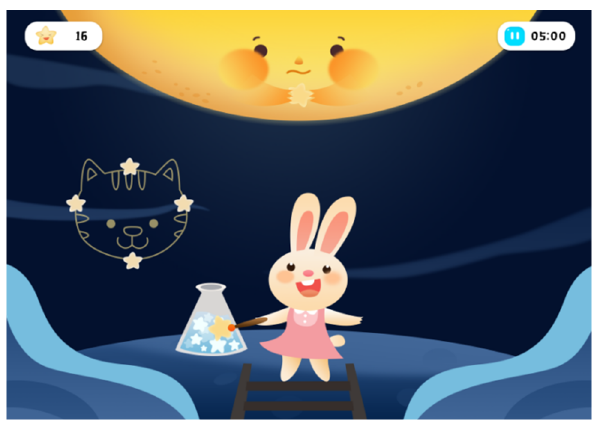
Figure 7. Higher difficulty of the alerting game (authors’ proposal).